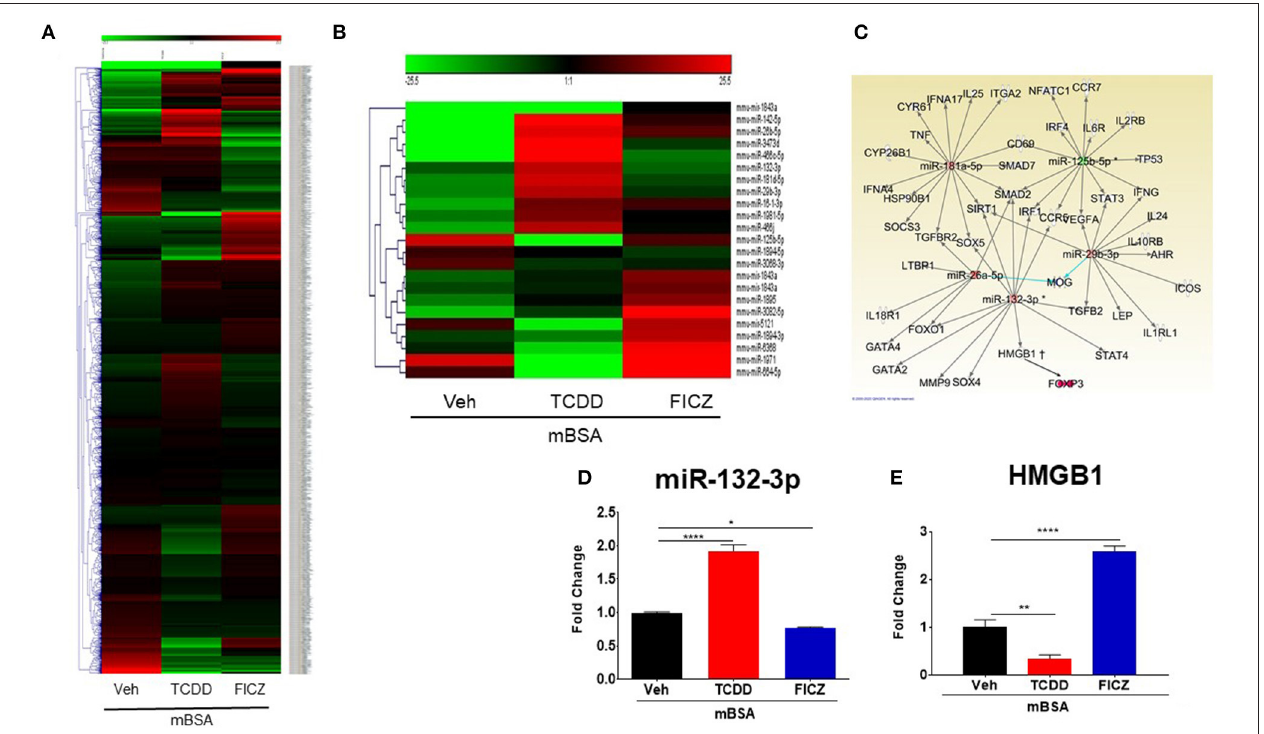
FIGURE 6 | miRNAs expression profile from cells isolated from DLN of mice with DTH and treated with VEH, TCDD, and FICZ. (A) Heat map showing miRNAs expression profile in cells of DLN from mice with DTH treated with VEH, TCDD, and FICZ. The expression array (green to red) represents the scale of downregulated to upregulated expression array of miRNAs, respectively. (B) Heat map representing fold change ( − 1.5, + 1.5 fold) expression profile of miRNAs that were significantly different between the groups. (C) IPA ingenuity software was used to establish interactions between miRNAs and the proinflammatory T cell pathway. (D) qRT-PCR validation of the expression of miR-132-3p in DLN cells. (E) qRT-PCR validation of mRNA expression of HMGB1 in DLN cells. Vertical bars represent Mean ± SEM and significant differences between groups are shown with asterisks (* p < 0.05, ** p < 0.01, **** p < 0.0001) based on one-way